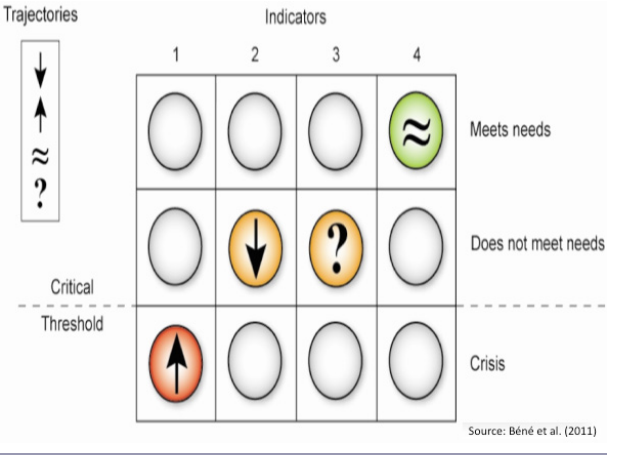
Fig. 2 . Visual approach to social